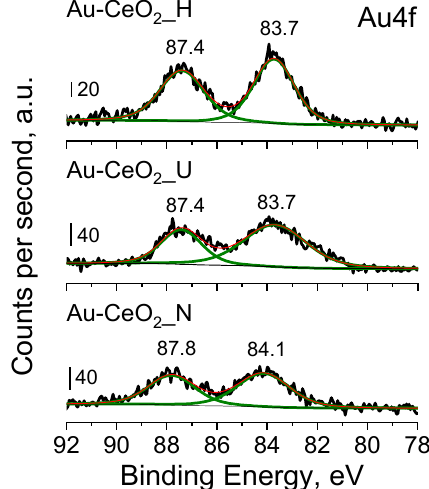
Figure 8. Au 4f XP spectra of catalysts.